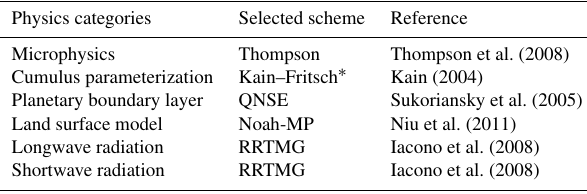
Table 1. Selected WRF_SA and WRF-H_FC model physical schemes. QNSE: quasi-normal scale elimination; RRTMG: Rapid Radiative Transfer Model for General Circulation